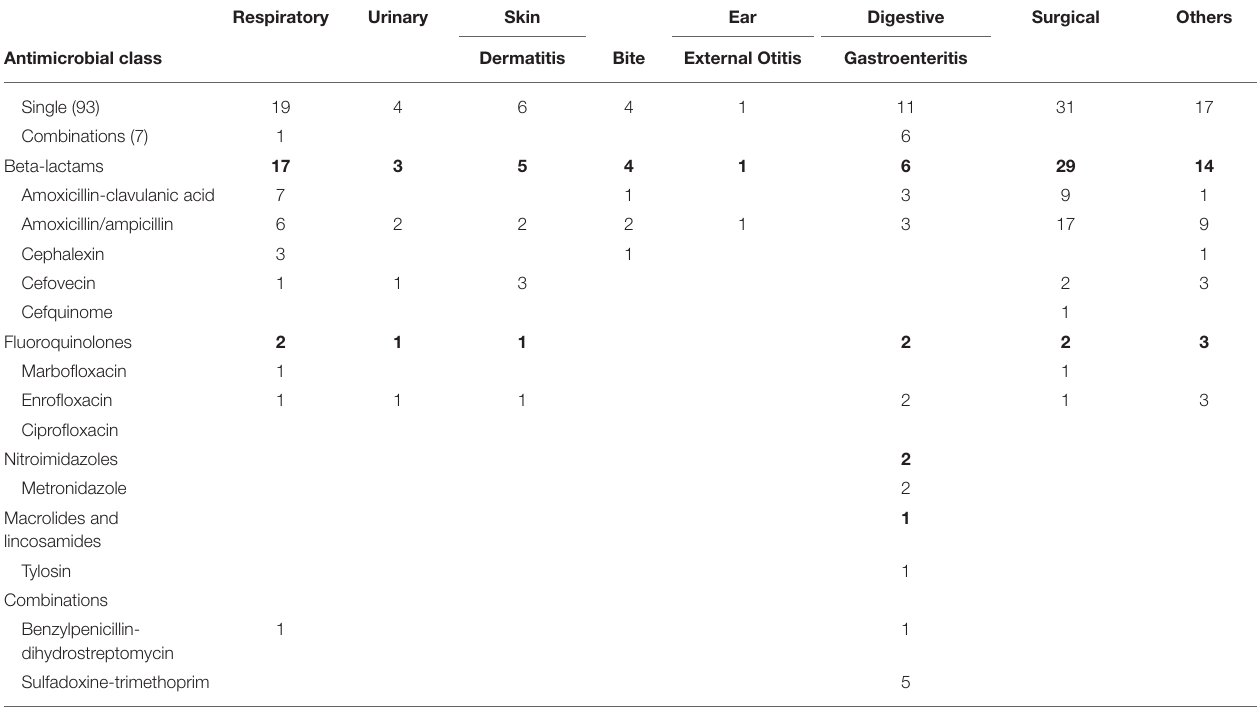
TABLE 3 | Distribution of antimicrobials of 100 parenteral medicinal products according to organ/system (conditions) treated, on 300 urban dogs (Madrid City). Respiratory Urinary Skin Ear Digestive Surgical Others Antimicrobial class